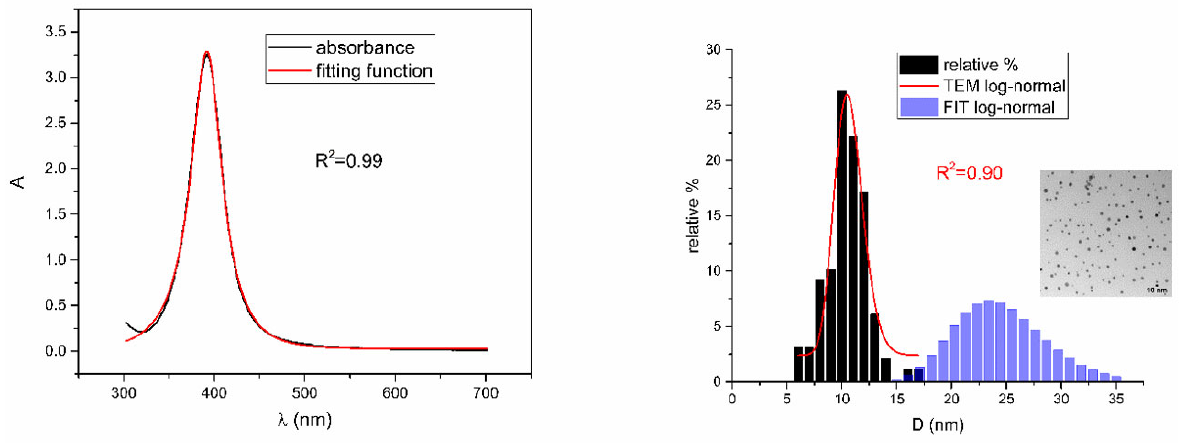
structed size distributions are shown on the right . size distributions are shown on the ( right ).